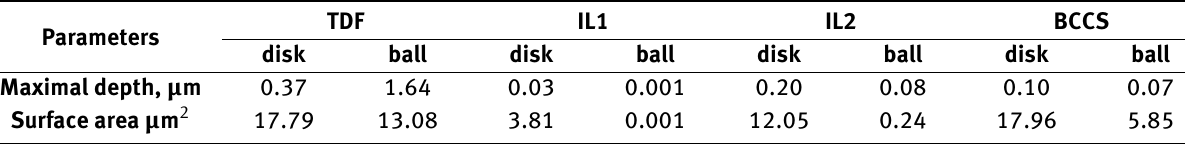
Table 3: Maximum depth and surface area of the disk and